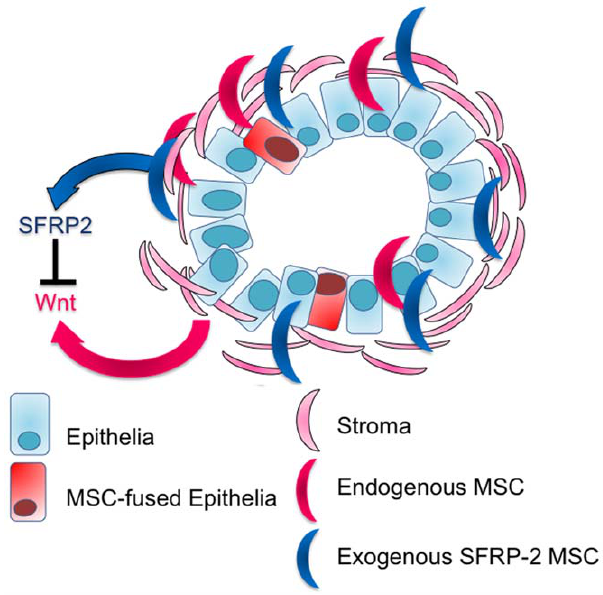
Figure 7. MSCs contribute to CRPC. This diagram represents a transformed prostate gland. Rounded turquoise rectangles indicate epithelial cells with an irregular nuclear shape and the larger pink half moon shapes represent the stromal compartment. The stroma surrounds the ducts, and is invaded by the transformed epithelia. The recruited endogenous-MSCs (red) contribute to Wnt signaling in CRPC. Whereas, the recruited therapeutic-MSCs that express SFRP-2 (blue) antagonize Wnt signaling in CRPC. Rounded red rectangles indicate epithelial cells that have fused with recruited MSCs.